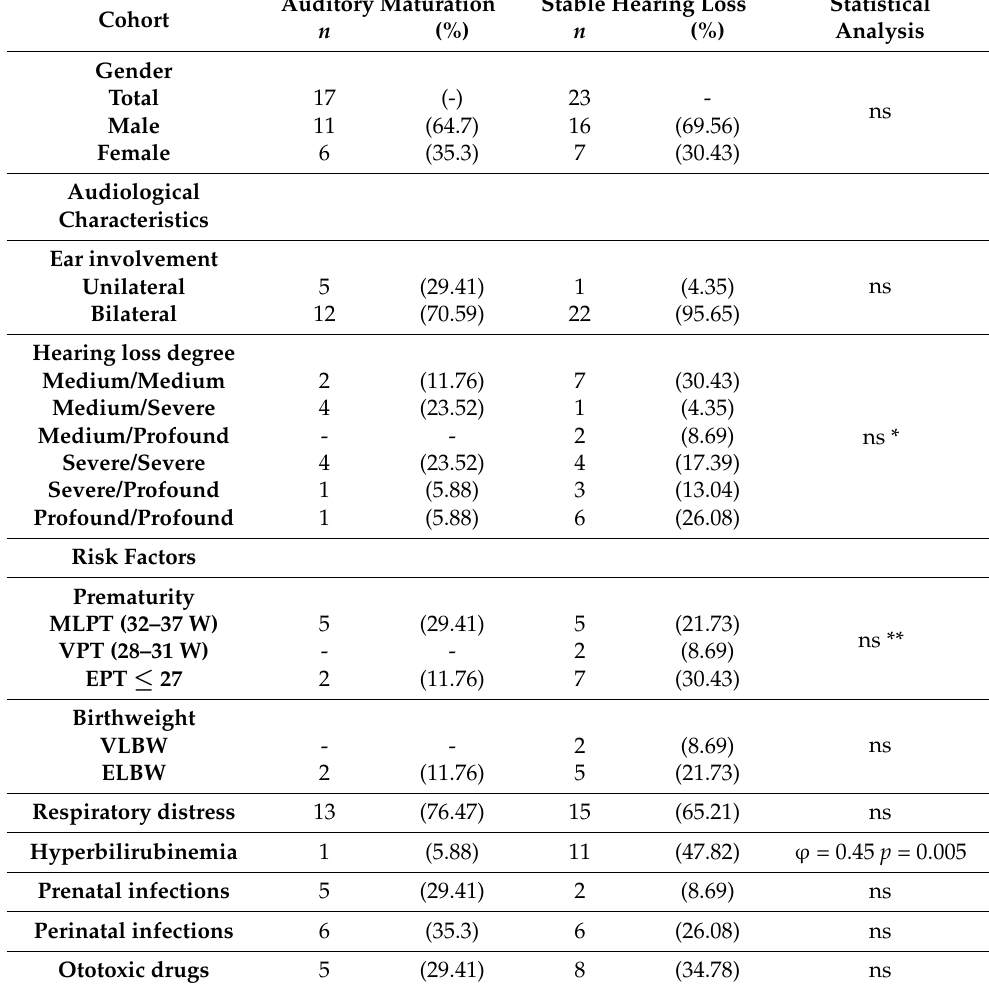
Table 2. Comparative study of children with permanent hearing loss and infants with auditory improvement. Auditory Maturation Stable Hearing Loss Statistical Cohort